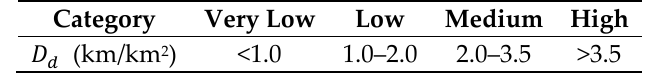
Table 2. Categorisation of drainage density given by Ravi Shankar and Mohan [21].